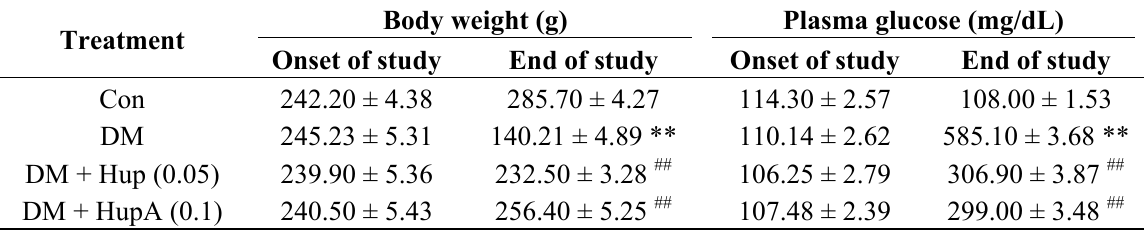
Table 1. Effect of HupA on body weight and blood glucose levels ( n = 8, mean ± S.D.) in the four groups of rats at the onset and at the end of the